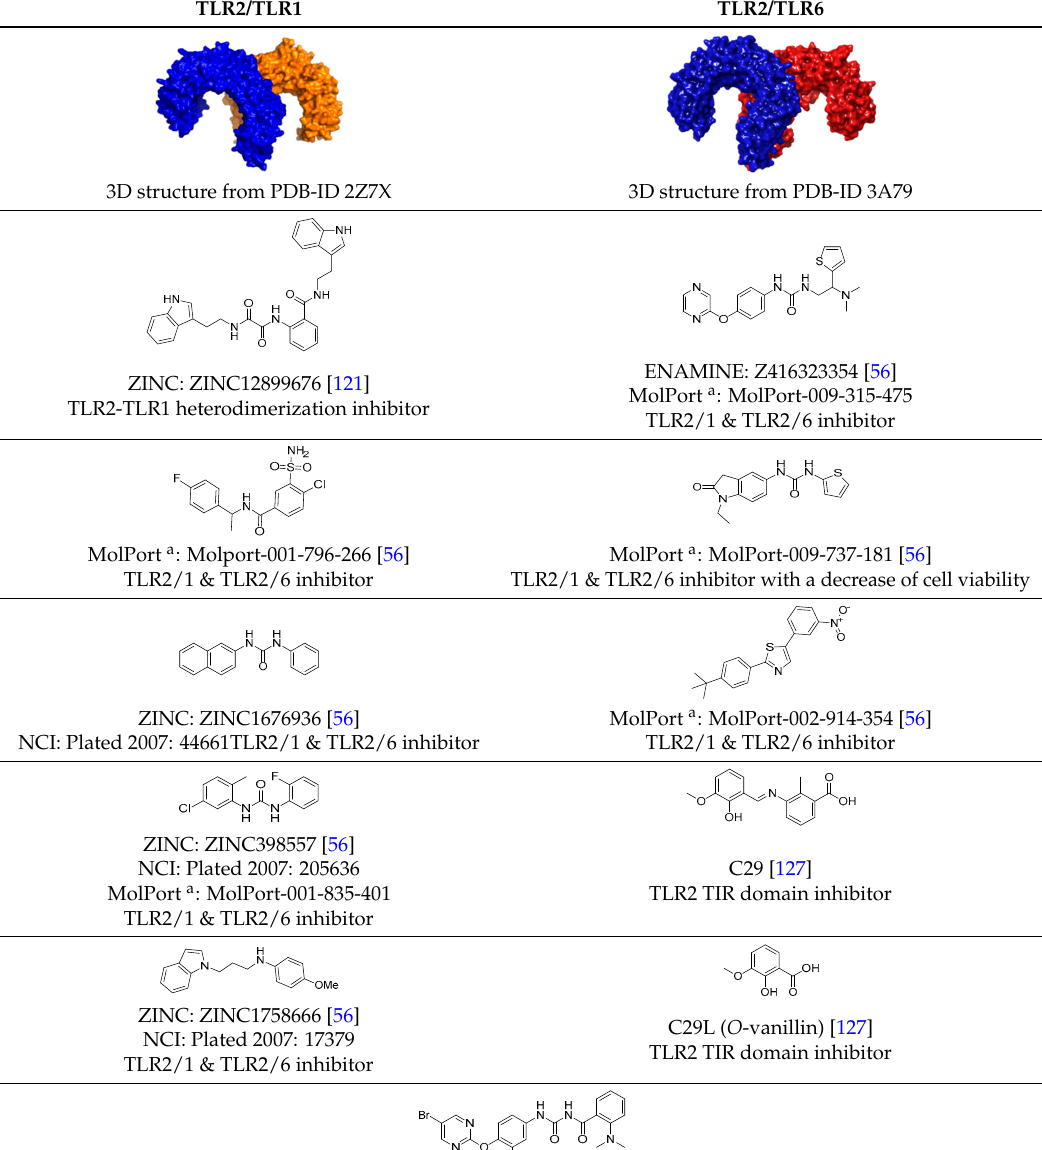
Table 2. 2D Chemical structure of TLR2 modulators identified by VS techniques and mentioned in this review. The database codes are provided. a MolPort is a supplier of chemicals included in several VS databases